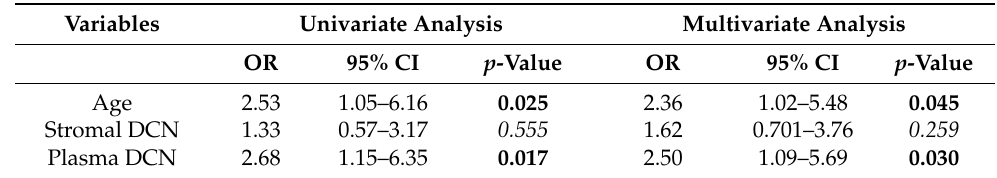
Table 2. Univariate analysis and multivariate logistic regression analysis associated with the ad- vanced stage.